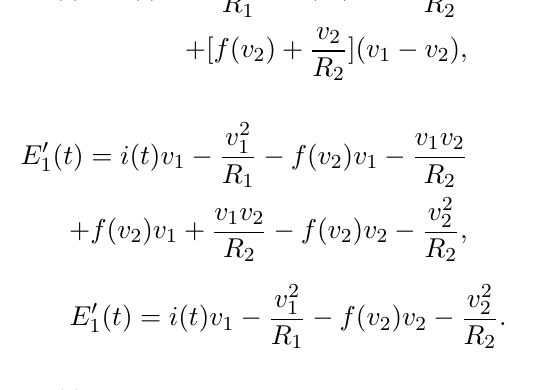
Figure 1. LRC circuit with nonlin- ear resistive